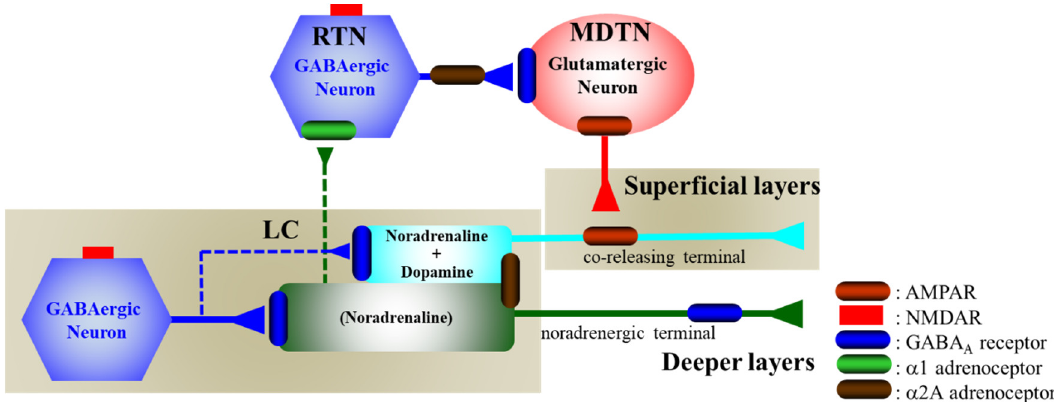
Figure 9. Proposed hypothesis for the extended neural circuitry involved in thalamocortical (RTN– MDTN–OFC) glutamatergic, mesothalamic (LC-MDTN) noradrenergic, and mesocortical (LC-OFC) catecholaminergic connectivity and their regulation systems. GABAergic neurones in the LC receive excitatory glutamatergic inputs via NMDAR. Both noradrenergic and catecholaminergic neurones